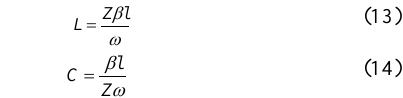
Figure 4. (a) A 50 Ω CPW, W is the wide of signal line and G is the gap between the signal and ground lines (80 and 60 µm respectively). (b) Lumped electrical models of MEMS capacitive shunt switch for both up and down state. C u is 91fF, C d is 2.87 pF, L is 4.3 pH and R is 0.04 Ω. (c) Comparing S 11 and S 21 for up and down states for both physical structure